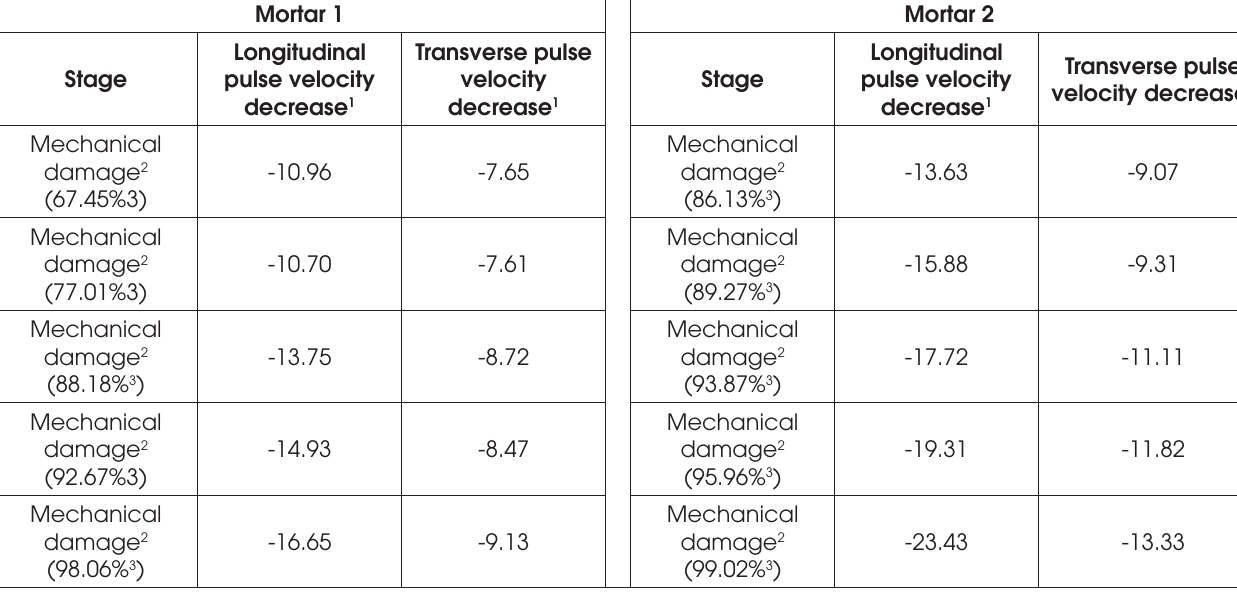
Ultrasonic wave velocities decrease calculated using the finite element